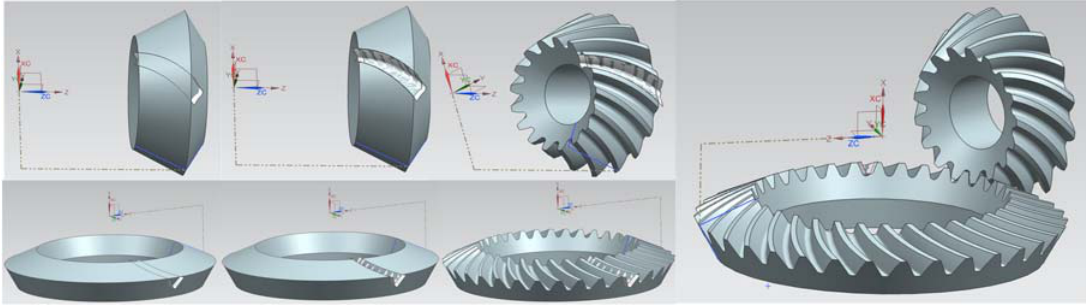
Figure 3. Gear design from 2D geometry to 3D geometry.